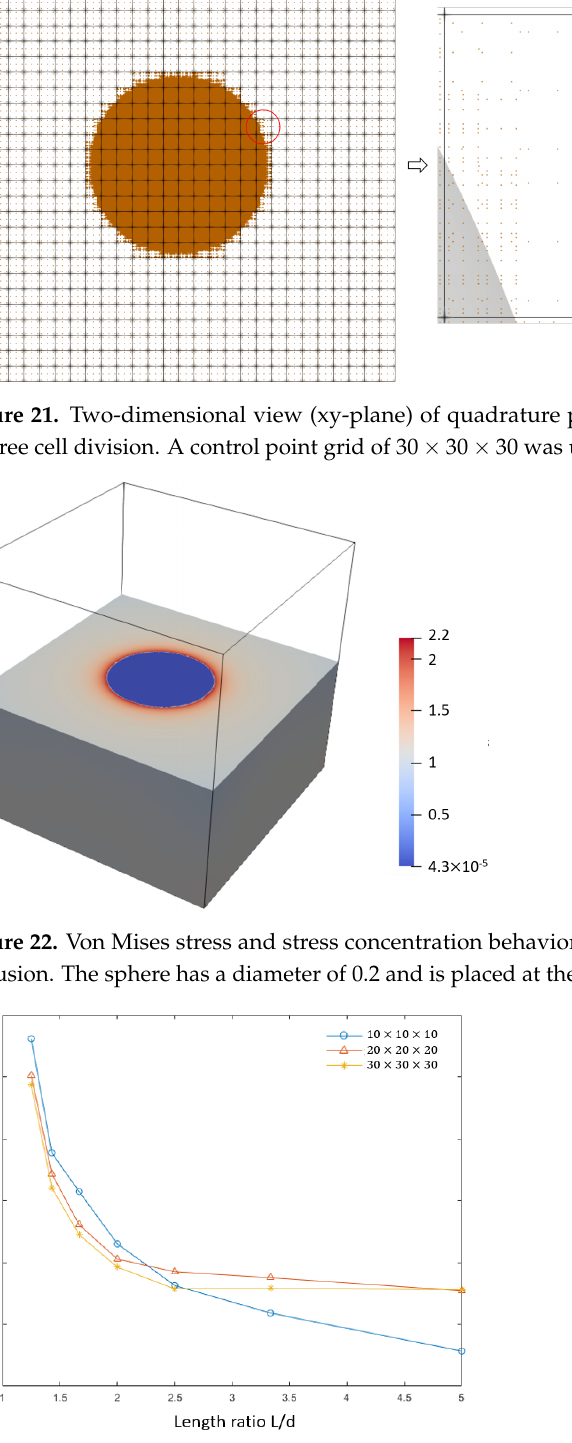
Figure 23. Convergence of the stress concentration factor with refinement as a function of the scale ratio L (where L is the size of the underlying cubic domain and d is the diameter of spherical void). d The plots correspond to 10 × 10 × 10, 20 × 20 × 20, and 30 × 30 × 30 control